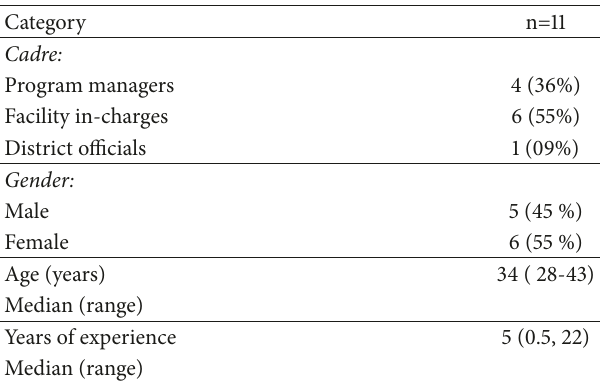
Table 4: Characteristics of key informants at health facilities and programs in Mbarara